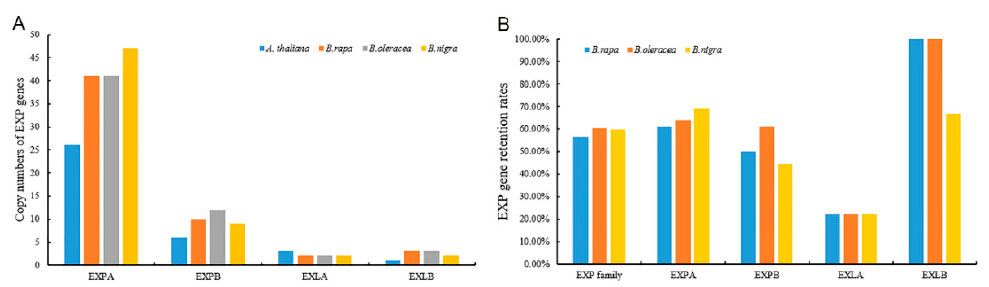
Figure 6. Copy numbers ( A ) and gene retention rates ( B ) of expansin genes in the four subfamilies and the three basic species of Brassica .